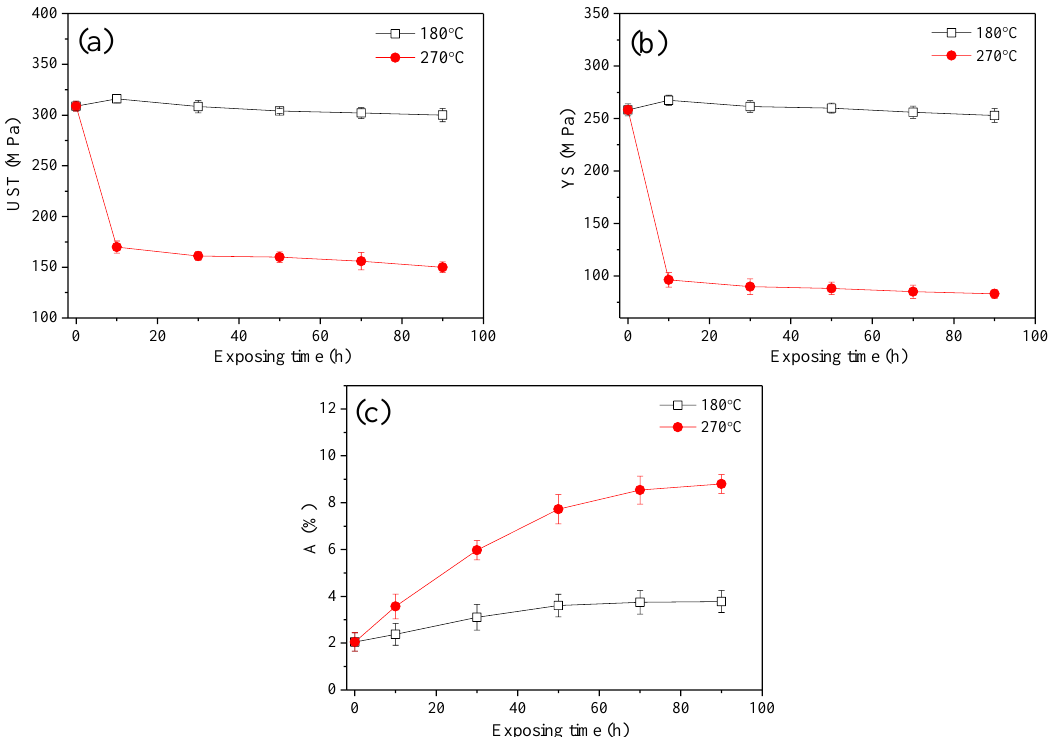
Figure 2. Tensile properties of the studied alloy versus exposure time: ( a ) UST, ( b ) YS and ( c ) A.